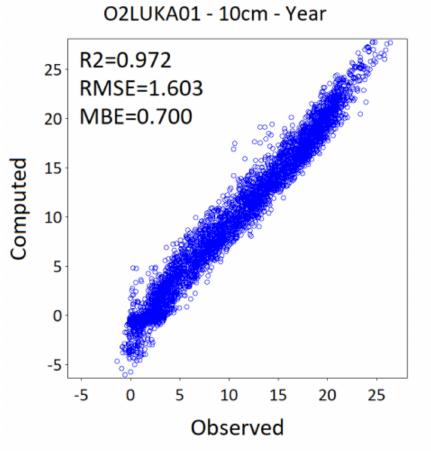
Figure A13. Validation at site O2LUKA01 for 10 cm soil depth.